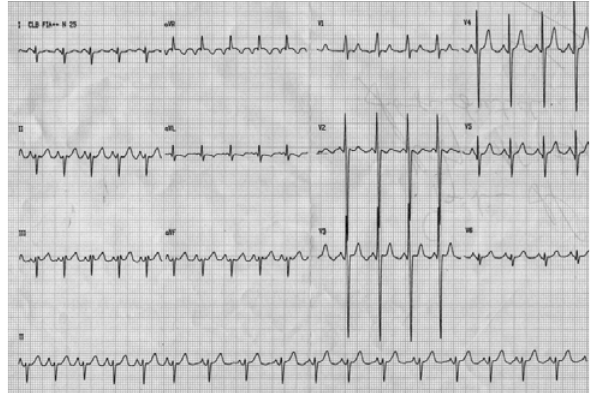
Fig. 1 – Eletrocardiograma